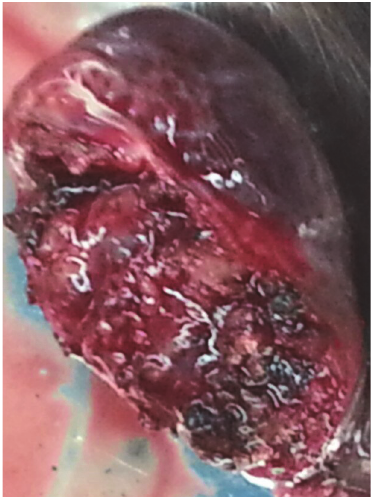
Figure 4: A complete resection of 4.2 cm mass of the azygos venous arch was performed and some thrombosis within the mass was